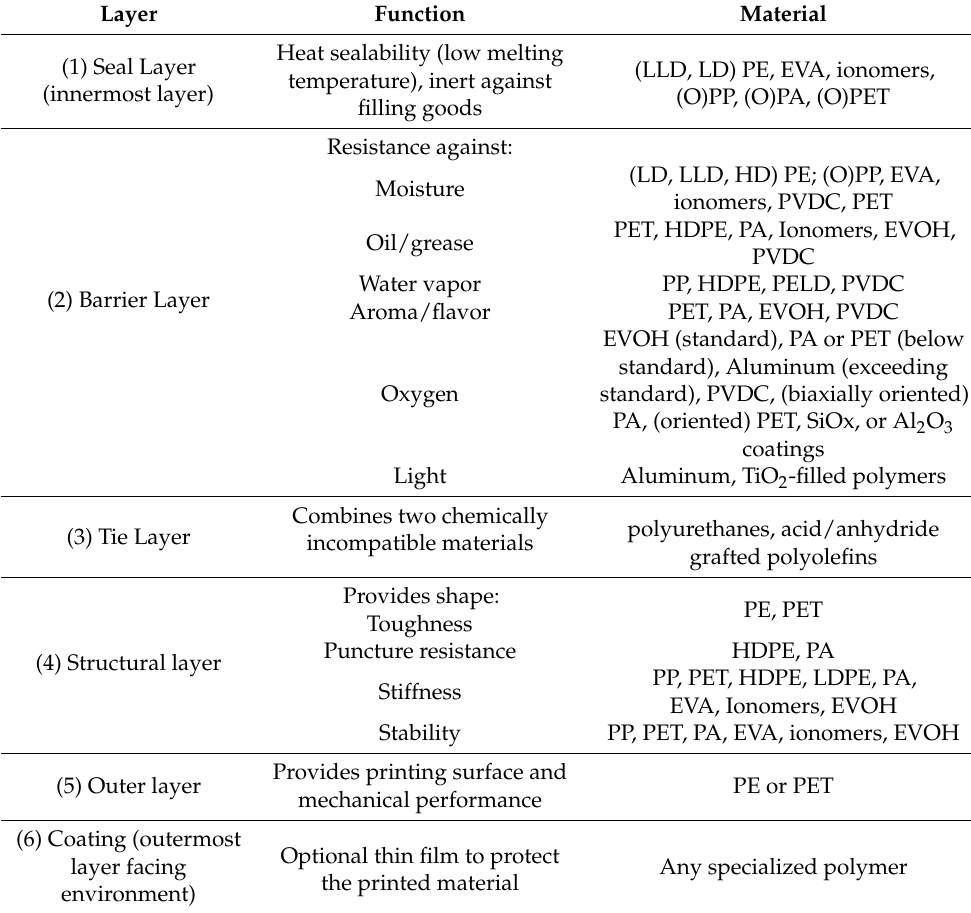
Table 1. Layers, functions, and commonly used materials for multilayer food packaging, based on [19,20,24,26,28,50,53–61]. Abbreviations used: LLD (linear low-density), LD (low-density), HD (high- density), PE (polyethylene), EVA (ethylene-vinyl acetate), OPP (oriented polypropylene), OPA (ori- ented polyamide), OPET (oriented polyethylene terephthalate), PVDC (polyvinylidene chloride), EVOH (ethylene-vinyl